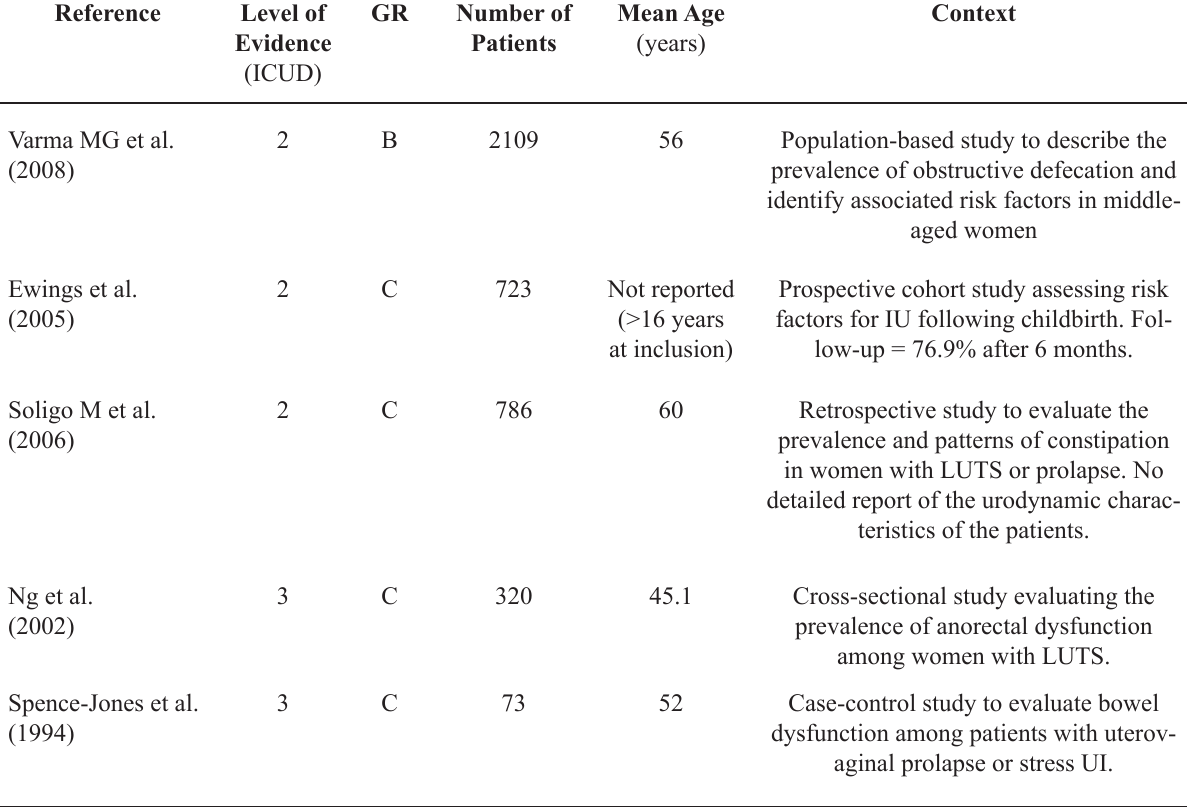
Table 4 – Literature data on constipation and LUTS in middle-aged women.